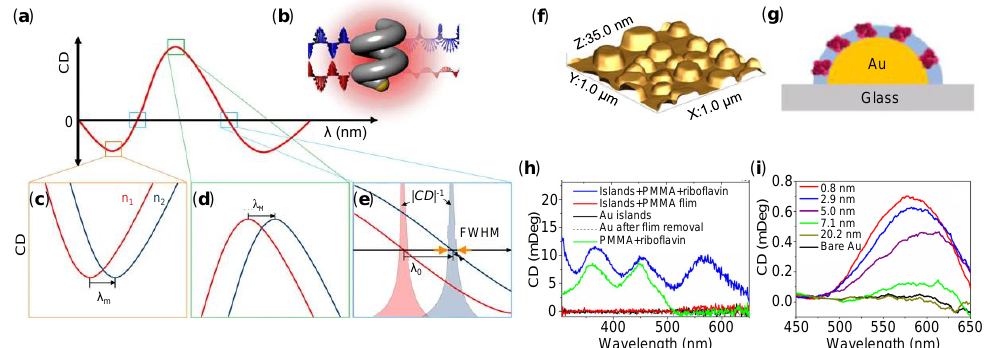
Figure 3. Plasmonic chiral sensors. ( a ) Circular dichroism (CD) spectra of a plasmonic enantiomer. ( b ) Illustration shows the interaction between a left-handed nanohelix and circularly polarized light. Three bottom panels indicate the resonance shifts at ( c – e ) where the RI of the surroundings are varied from n 1 and n 2 . ( f ) Atomic force microscope (AFM) images of gold-island films. ( g ) Scheme of gold islands covered with polymers which includes embedded riboflavin molecules. ( h ) CD spectra for different hybrid plasmonic structures. ( i ) CD spectra from Riboflavin derivative with different separation from the gold surface, together with a bare gold CD spectrum. Reprinted ( a – e ) with permission from Reference [91]. Reprinted ( f – i ) with permission from Reference